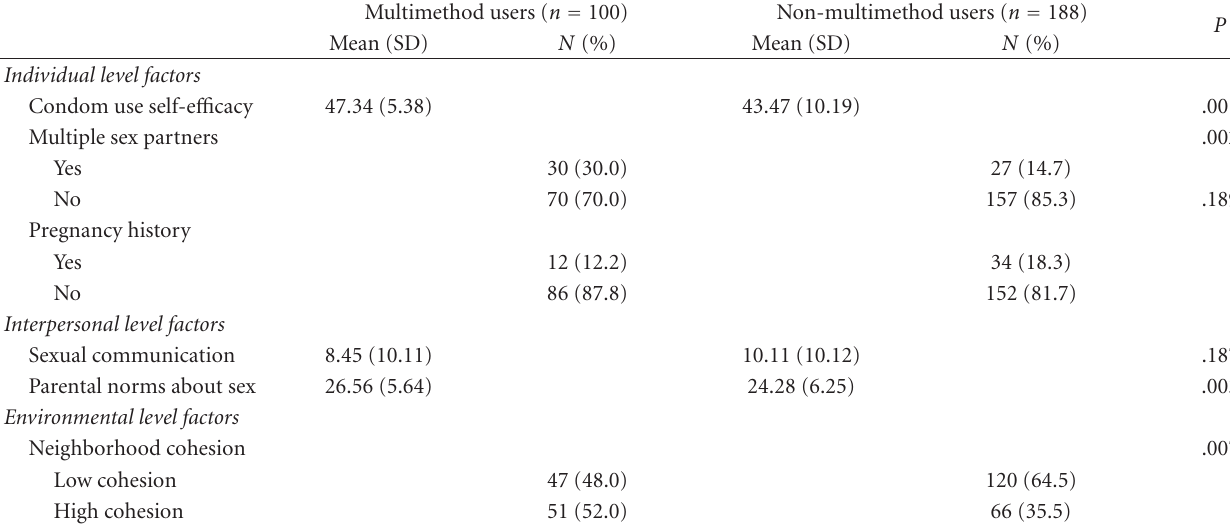
Table 2: Bivariate associations between study variables and multimethod use and non-use. Multimethod users ( n =